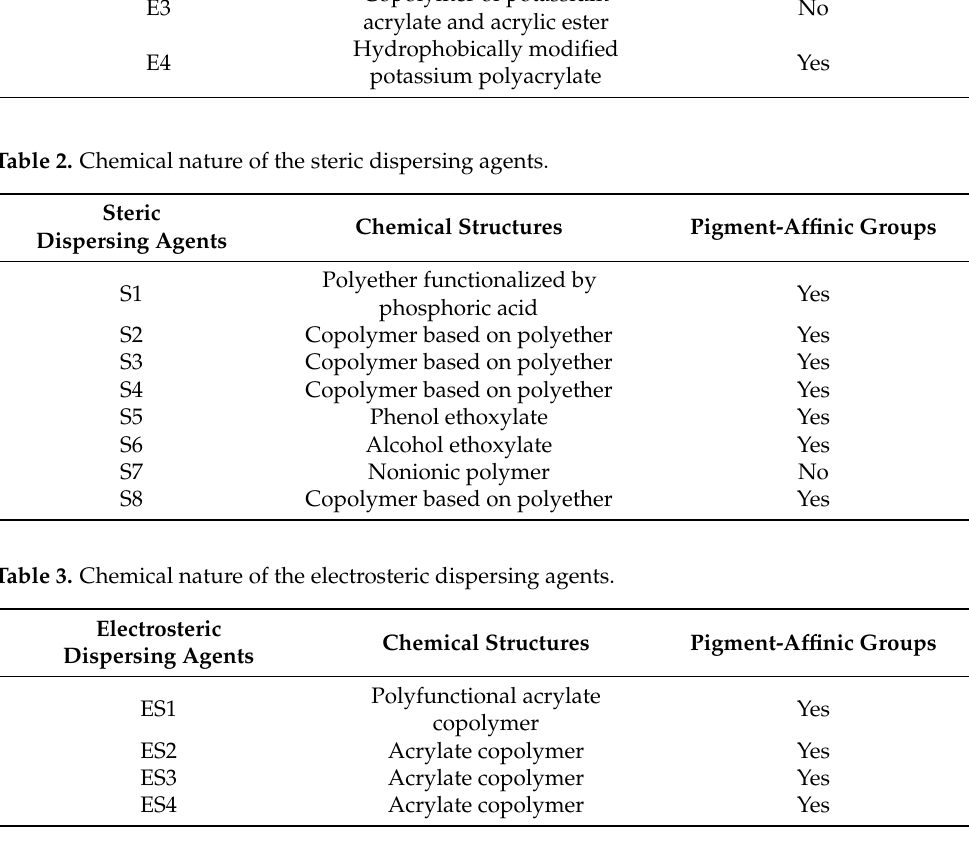
Table 1. Chemical nature of the electrostatic dispersing agents. Electrostatic